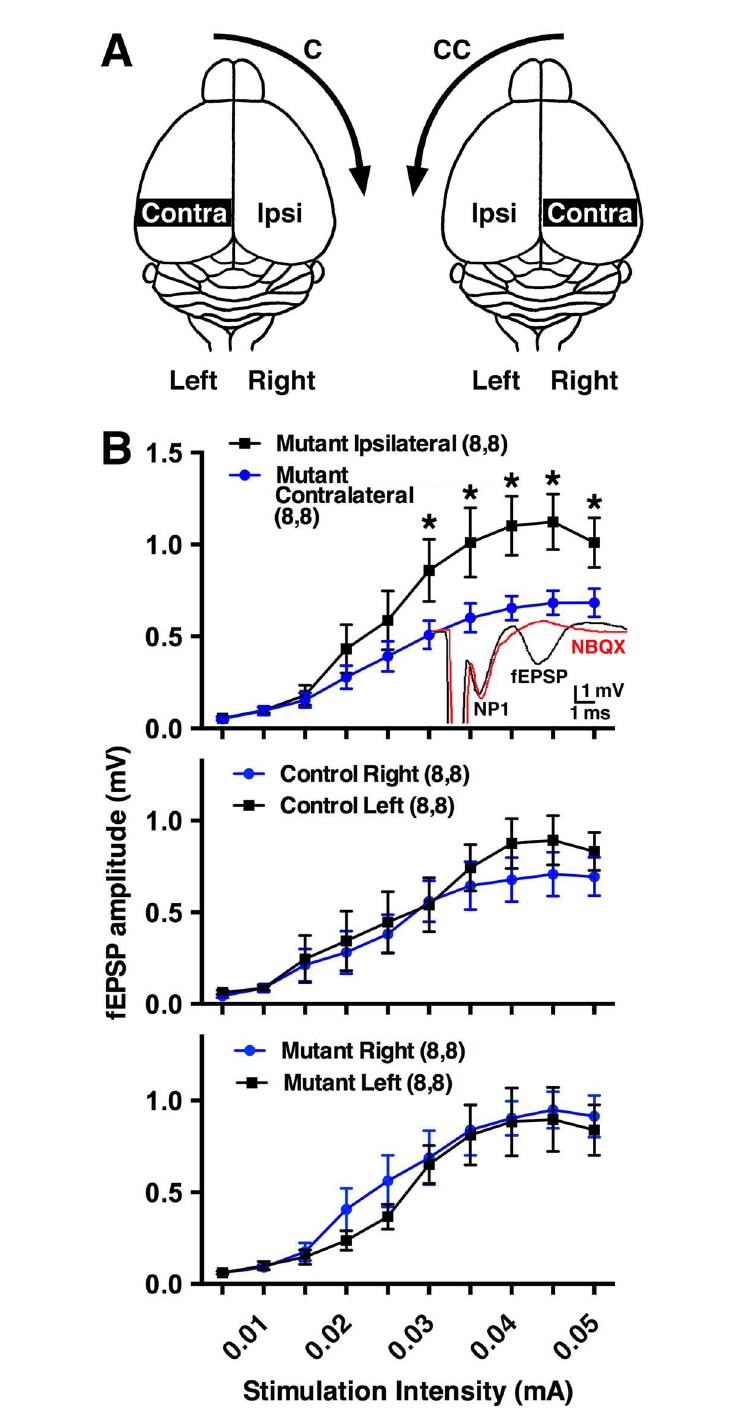
Fig 2. Electrophysiological asymmetry in the cerebral hemispheres correlates with the preferred turning direction. (A) Illustration of the contralateral and ipsilateral hemispheres regarding turning direction. (B) fEPSPs were greater ( p = 0.017) on the ipsilateral compared to contralateral side in Slc12a2 K842 (cid:3) /K842 (cid:3) mice. Inset: standard cortico- striatal fEPSP recording (black) and the sensitivity of the EPSP component to NBQX, an AMPA receptor antagonist (red); NP1: presynaptic fiber volley. fEPSPs between left and right hemispheres of littermate controls ( p = 0.94) or of mutants ( p = 0.96). Numbers in parentheses: number of recordings, number of mice. Mean ± SEM, two-way repeated measures ANOVA. See also S1 Data. AMPA, α -amino-3-hydroxy-5-methyl-4-isoxazolepropionic acid; C, clockwise; CC, counterclockwise; EPSP, excitatory postsynaptic potential; fEPSP, field excitatory postsynaptic potential; NP1, negative peak 1; SEM, standard error of the